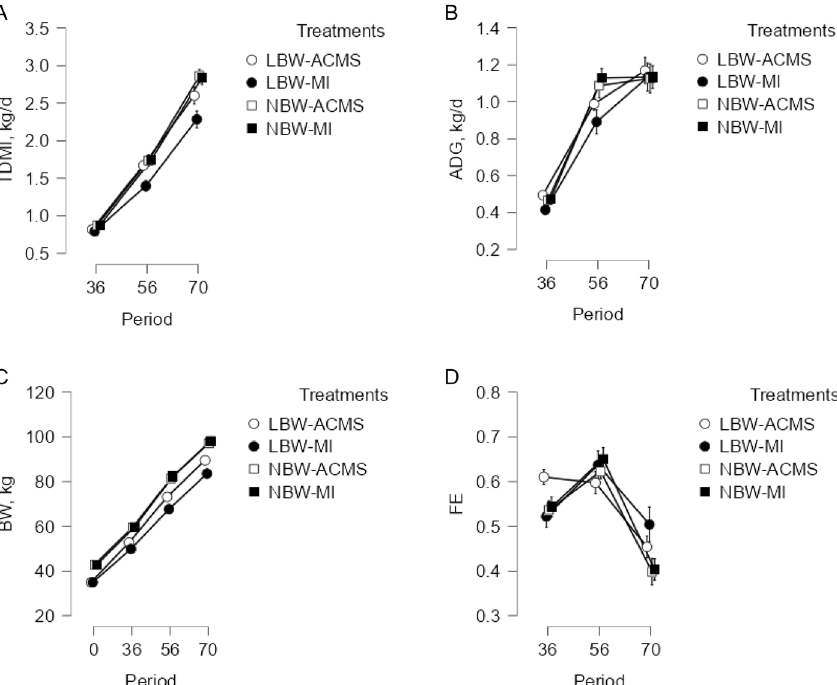
Figure 2. ( A ) total dry matter intake (TDMI), ( B ) average daily gain (ADG), ( C ) body weight (BW), and ( D ) feed efficiency (FE) of calves with different birth body weights (n = 13 per treatment) fed diets with different mineral sources. Values are presented separately for normal birth weight calves fed diets containing an advanced chelated mineral source (NBW-ACMS; ● ), for normal birth weight calves fed diets containing an inorganic mineral source (NBW-IM; ○ ), for low birth weight calves fed diets that contained an advanced chelated mineral source (LBW-ACMS; ▼ ), and for low birth weight calves fed diets that contained an inorganic mineral source (LBW-IM; ∆) are presented. Data are presented as mean ±